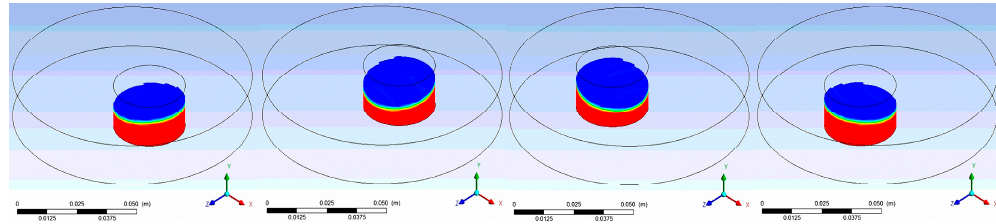
Figure 2. The shapes and surfaces (in blue) of the liquid (in red) in the container during a period, where the container is rotated at 120 rpm, i.e., the period is 2 s, along an orbital path with 1 cm diameter. For each position, from left to right, the simulating time is 0.625 s and the time increment is 0.5 s. The coordinate is XYZ system. (Container’s diameter = 3 cm)